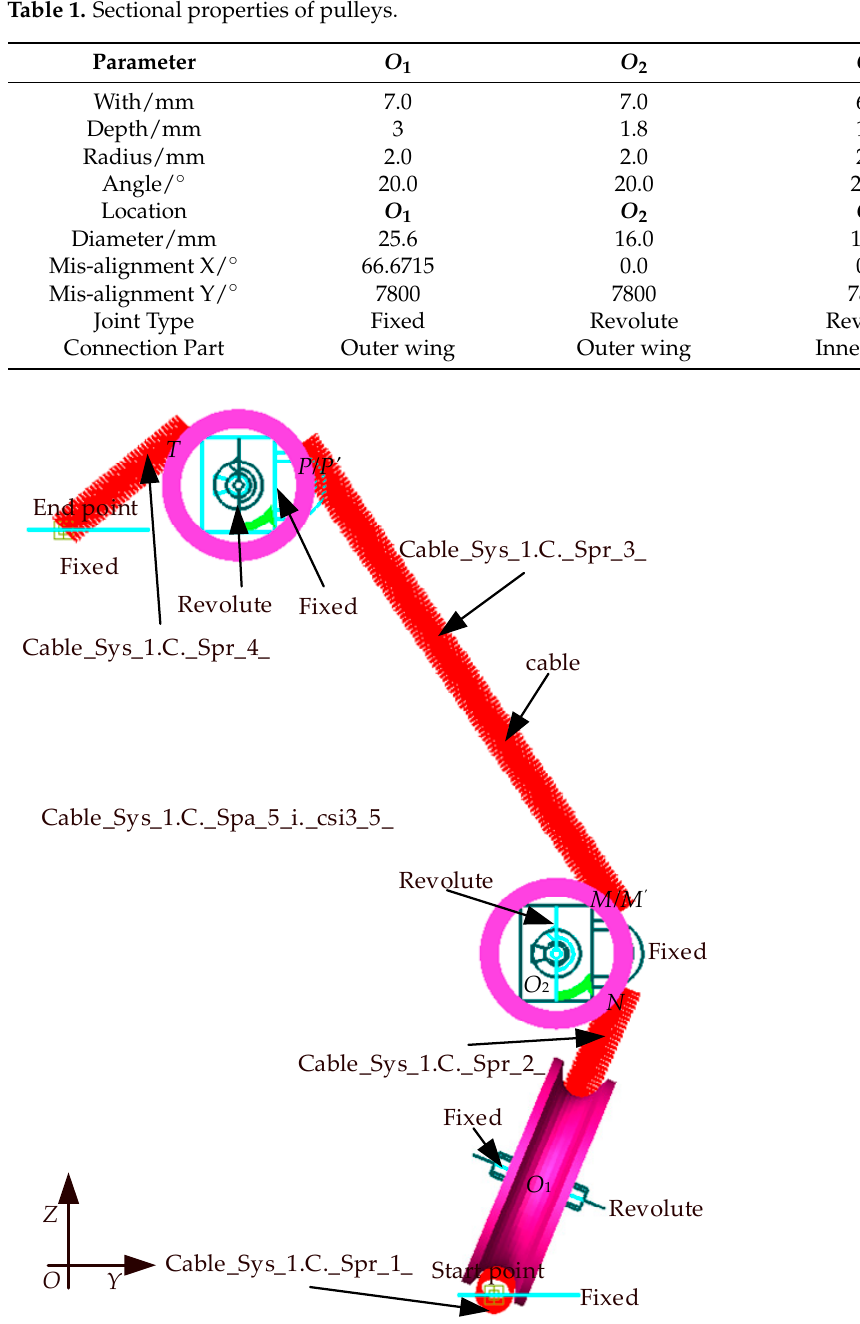
Figure 5. Simulation model of transmission system.